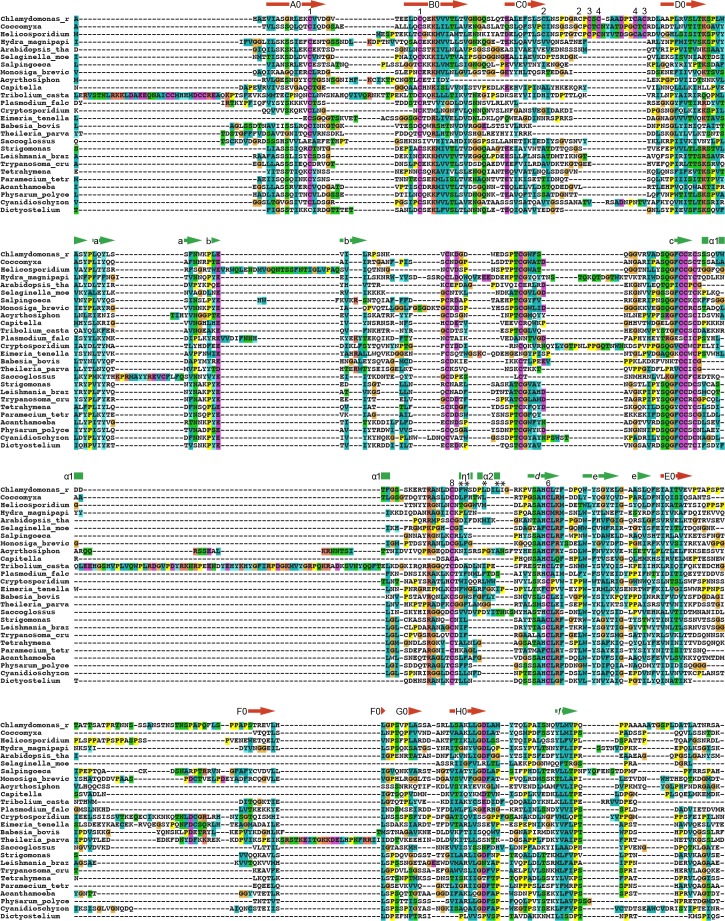
HAP2 sequences from representatives of different phylogenetic groups, selected for short length, and aligned with MAFFT as described in Main Text Fig. 3.Figure 3 legend. Only the mature sequence omitting the cytoplasmic domain is shown.